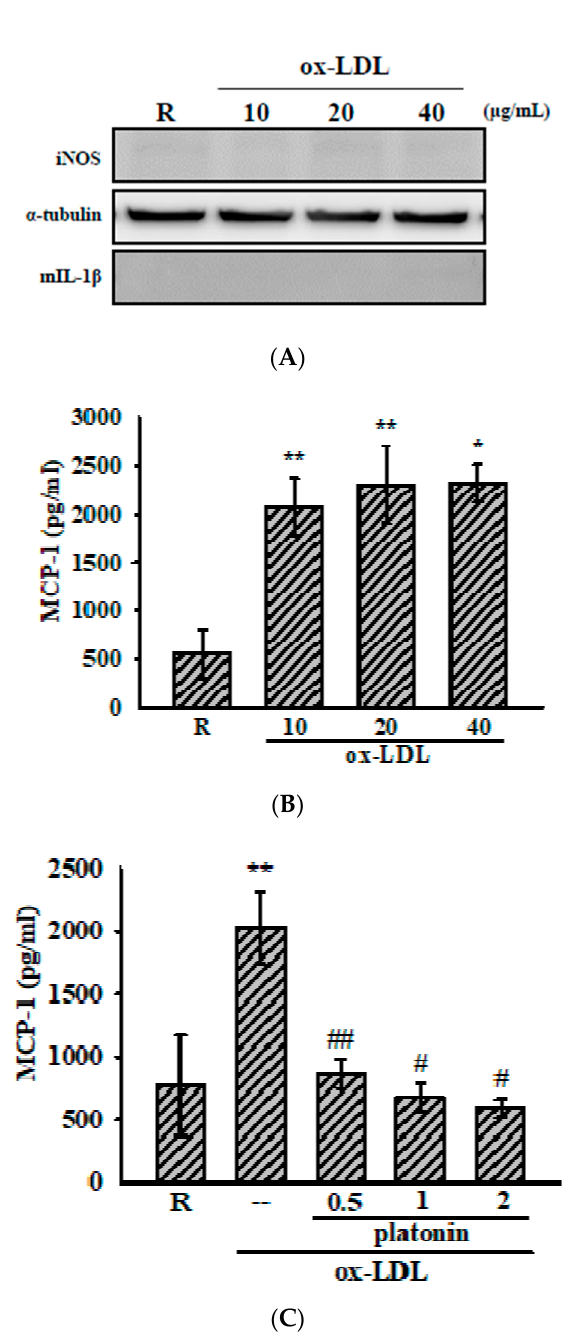
Figure 2. Platonin suppresses ox-LDL-induced production of monocyte chemoattractant protein-1 (MCP-1) in vascular smooth muscle cells (VSMCs). VSMCs were pretreated without ( A , B ) or with ( C ) platonin (0.5–2 μ M) for 30 min and then stimulated with ( A , B ) ox-LDL (10–40 μ g/mL) or ( C ) ox-LDL (20 μ g/mL) for 48 h. Western blotting assay was used to determine the cytosolic expression of iNOS and mIL-1 β content in the medium. MCP-1 production was determined using the ELISA kit as described in “Materials and Methods.” Data are presented as mean ± S.E.M. ( n = 3); * p < 0.05, ** p < 0.01, compared with the resting (R) group; # p < 0.05, ## p < 0.01 compared with the positive control group.